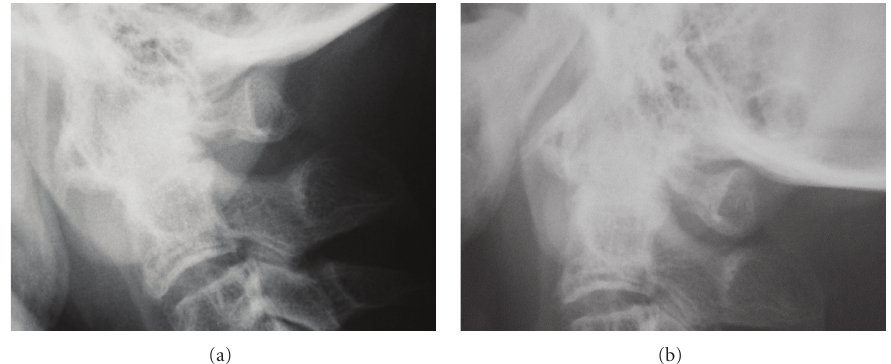
Figure 1: Preoperative dynamic lateral plain radiographs. Flexion view (a) and extension (b) view. Preoperative plain radiographs in flexed position (a) and in extended position (b) showed ossified mass behind dens and irreducible atlantoaxial subluxation. The atlantodental interval is 6mm and the space available for the spinal cord is 7 mm in each positions.